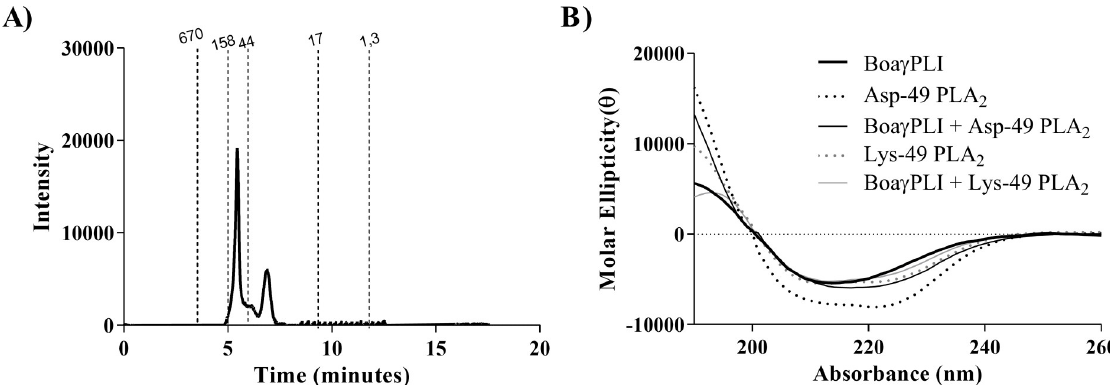
Fig 3. Structural analysis of the Boa γ PLI. A) Chromatographic profile on BioSep SEC S-2000 size-exclusion chromatography of Boa γ PLI (20 μ g), at a flow of 1 mL / min, monitored by 280 nm. B) Spectra of Asp-49 and Lys-49 PLA 2 s isolated, Boa γ PLI isolated and PLA 2 s + Boa γ PLI incubated (30 μ g) obtained by circular dichroism. The data were expressed in molar ellipticity.